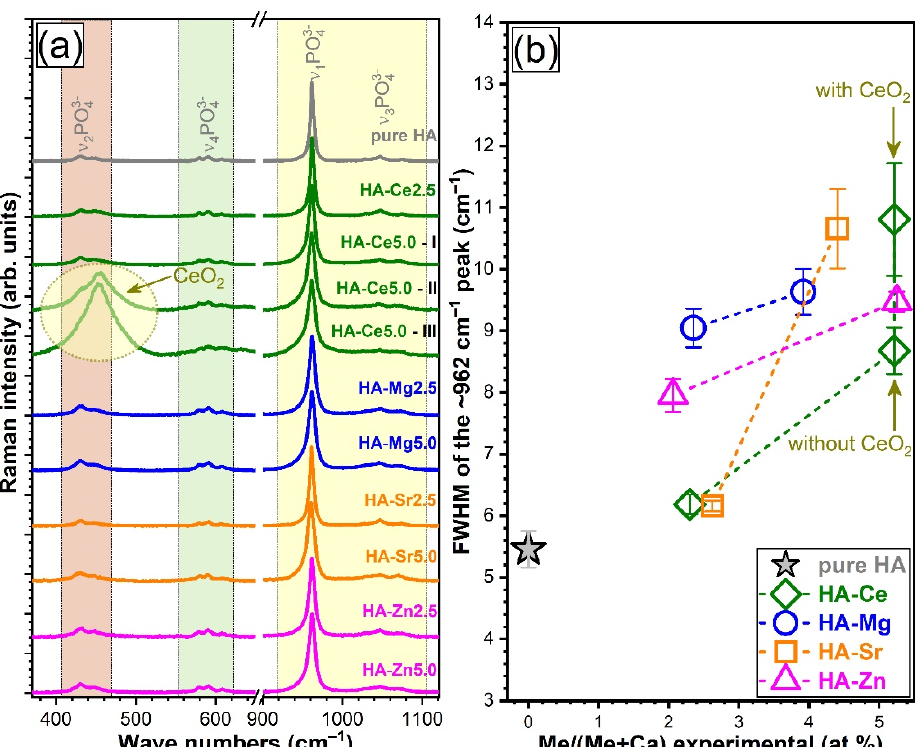
Figure 5. ( a ) Micro-Raman spectra for the pure and substituted HAs (2.5 and 5 at.%), collected in the wave number range 370–1120 cm − 1 and the ( b ) corresponding full-width at half maximum (FWHM) values of the ν 1 symmetric stretching mode band (~962 cm − 1 ).